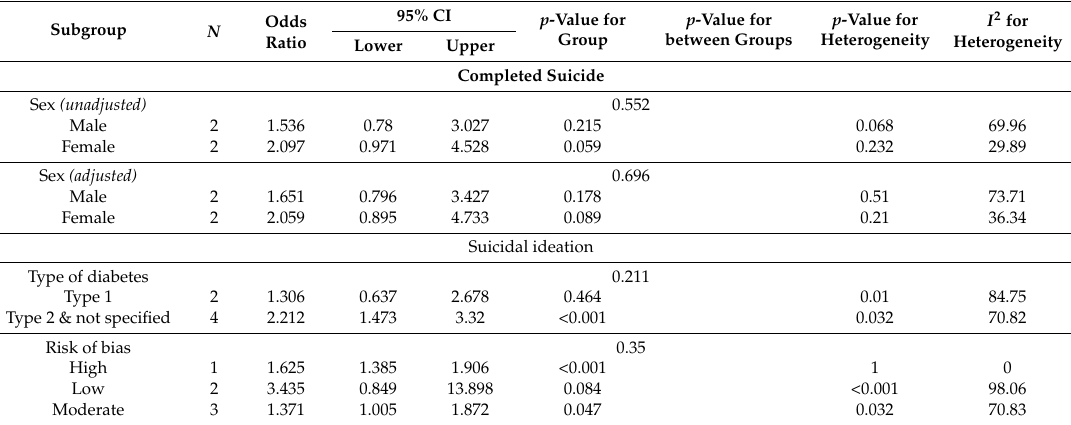
Table 6. Results for subgroup analysis for suicide and suicidal